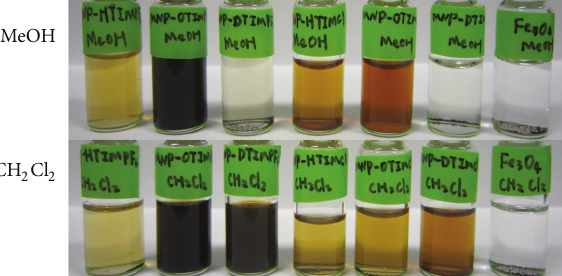
Figure 6: Solubility of the naked and modified MNPs in methanol and CH 2 Cl 2